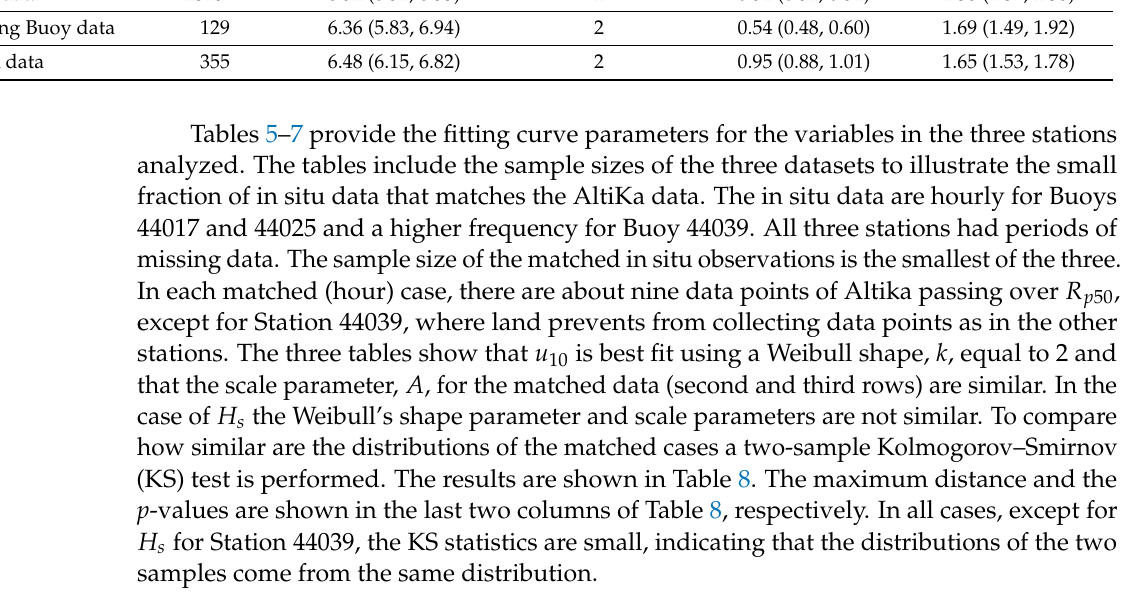
Table 8. Two sample Kolmogorov–Smirnov test results between IGDR-corresponding buoy data and R p 50 IGDR data.